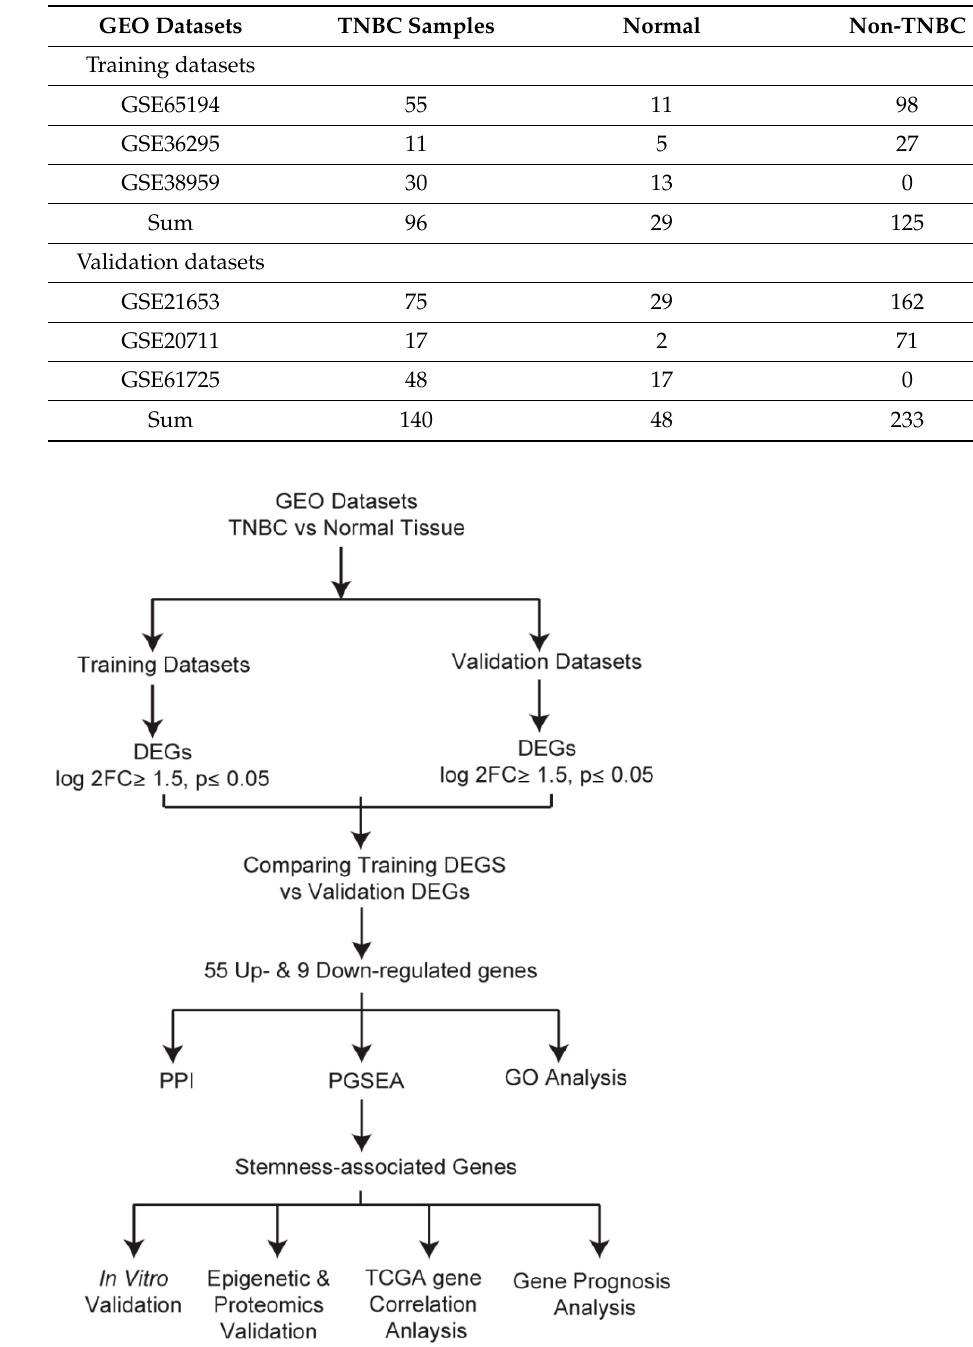
Figure 1. Workflow of the study. In total, six datasets containing TNBC samples were collected from the GEO database and randomly divided into the training or validation groups. Differentially expressed genes were analyzed in the training and validation groups and the common genes found were subjected to further analysis. A total of 64 differentially expressed genes constituting 55 upregulated and 9 downregulated genes were identified. PPI and gene function analysis were performed to evaluate the enriched terms of the common genes. Analyses of genes with the common expression pattern and shared common BP terms were performed using PGSEA. The five genes identified were further validated and evaluated for their potential role in the regulation of CSCs